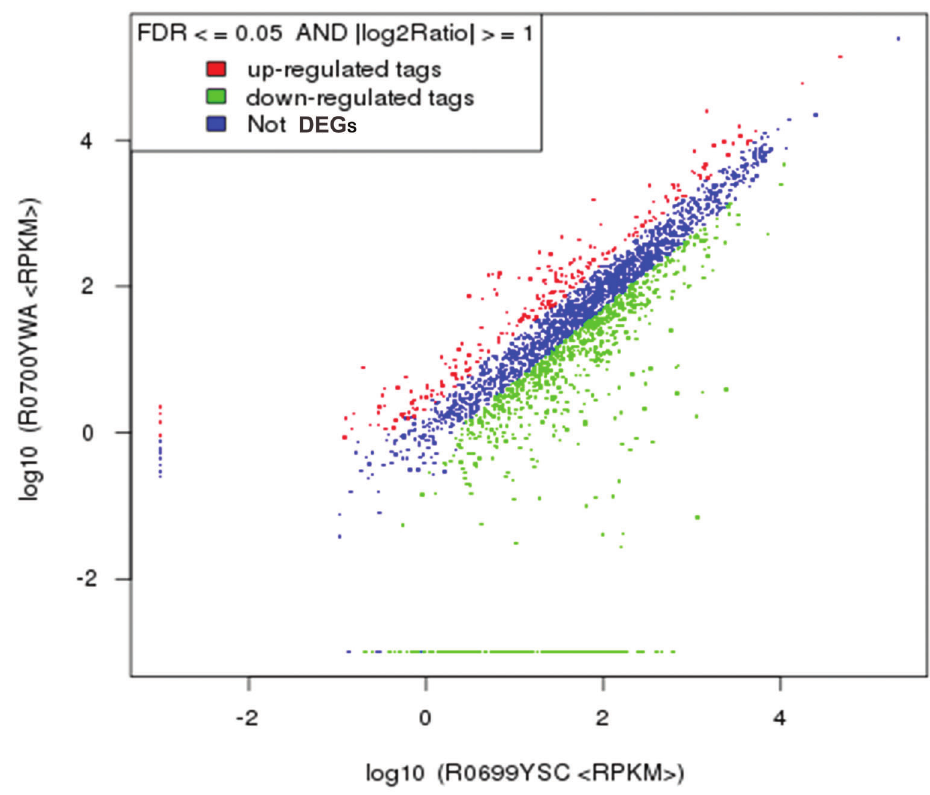
Figure 1. Differentially expressed genes (DEGs) in the multidrug resistance (MDR) isolate strain of C. perfringens. The red color represents up-regulated tags, the green color represents down-regulated tags (fold change) and the blue color represents no signi fi cant DEGs. FDR: false discovery